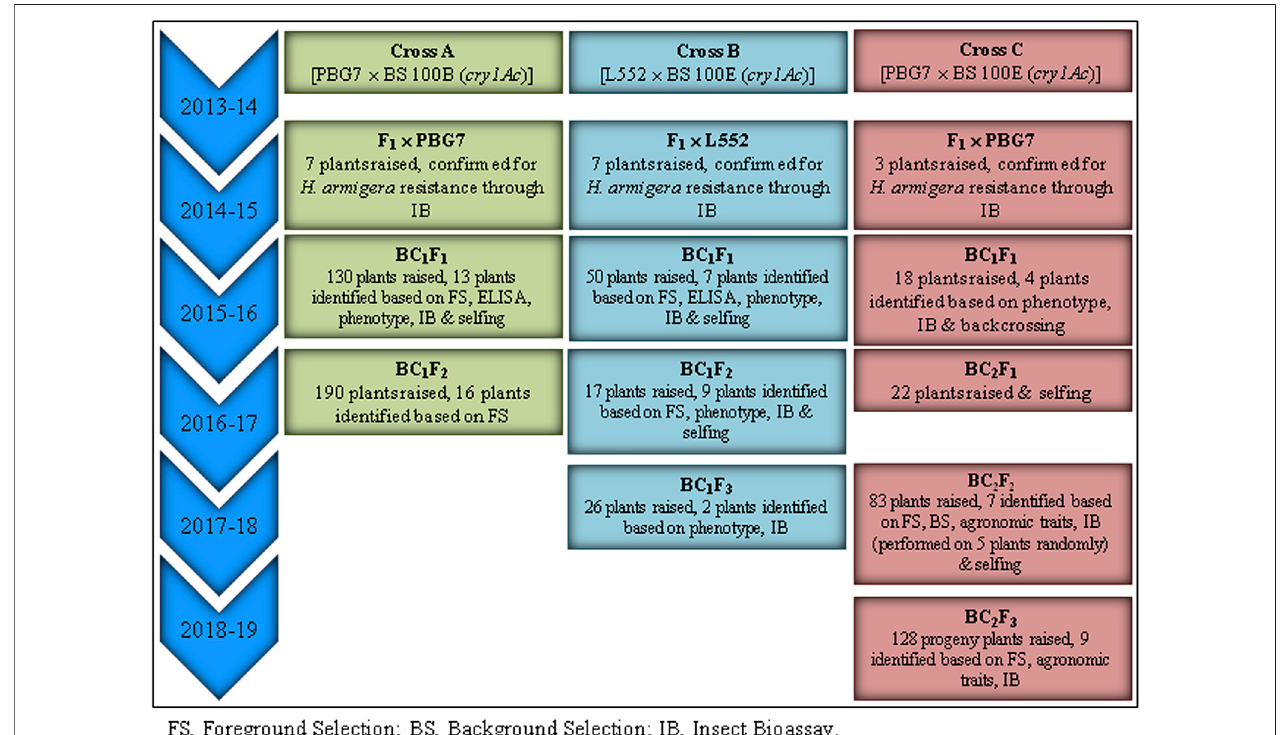
FIGURE 1 | Schematic overview of marker-assisted backcross breeding of commercial chickpea cultivars × transgenic lines.